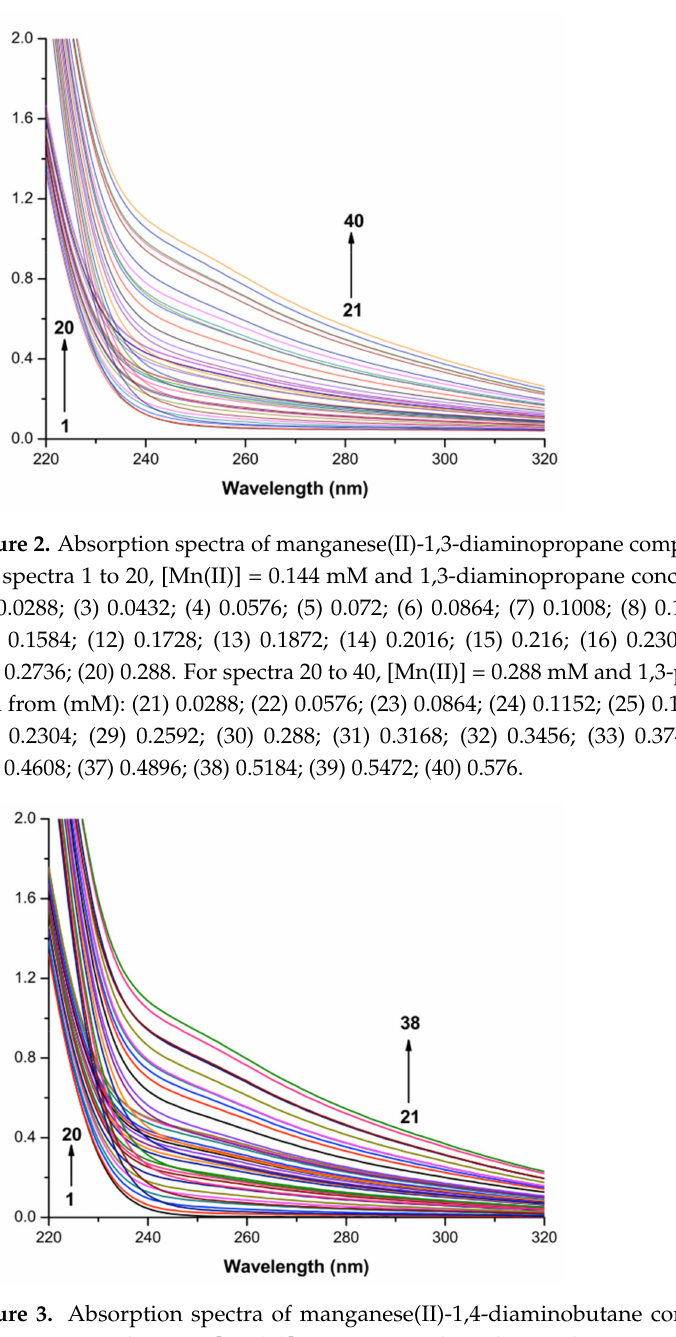
Figure 3. Absorption spectra of manganese(II)-1,4-diaminobutane complexes in methanol solu- tion. For spectral 1 to 20, [Mn(II)] = 0.16mM and 1,4-diaminobutane concentration (mM): (1) 0.016; (2) 0.032; (3) 0.048; (4) 0.064; (5) 0.08; (6) 0.096; (7) 0.112; (8) 0.128; (9) 0.144; (10) 0.16; (11) 0.176; (12) 0.192; (13) 0.208; (14) 0.224; (15) 0.24; (16) 0.256; (17) 0.272; (18) 0.288; (19) 0.304; (20) 0.32. For spectra 21 to 38, [Mn(II)] = 0.32 mM and 1,4-butanediamine from (mM): (21) 0.032; (22) 0.064; (23) 0.096; (24) 0.128; (25) 0.16; (26) 0.192; (27) 0.224; (28) 0.256; (29) 0.288; (30) 0.32; (31) 0.352; (32) 0.384; (33) 0.416; (34) 0.448; (35) 0.48; (36) 0.512; (37) 0.544; (38)